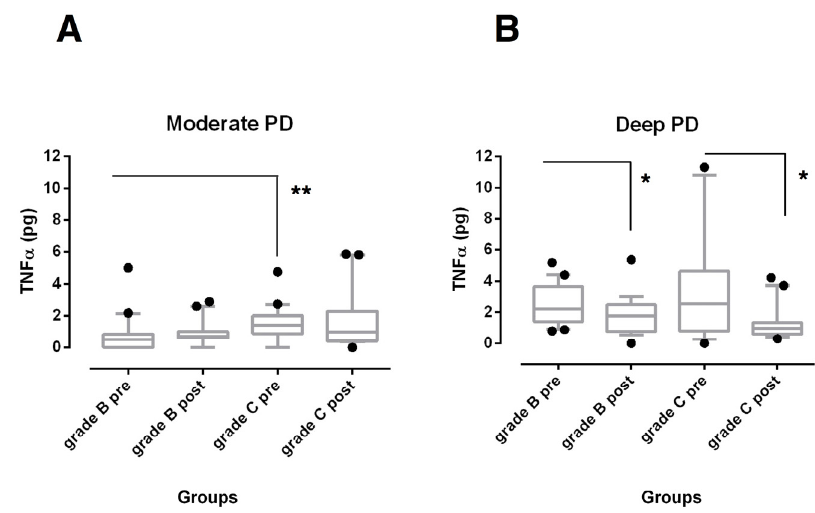
Figure 2. Box-and-whisker plots showing the total amount of tumor necrosis factor (TNF)- α in gingival crevicular fluid of moderate ( A ) and deep pocket sites ( B ) in subjects with grade B and grade C stage III periodontitis before (pre) and after non-surgical periodontal therapy (post). Horizontal line represents the median with the box representing the 25th and 75th percentiles, and the whiskers denote the 5th and 95th percentiles. * p < 0.05, ** p < 0.01.